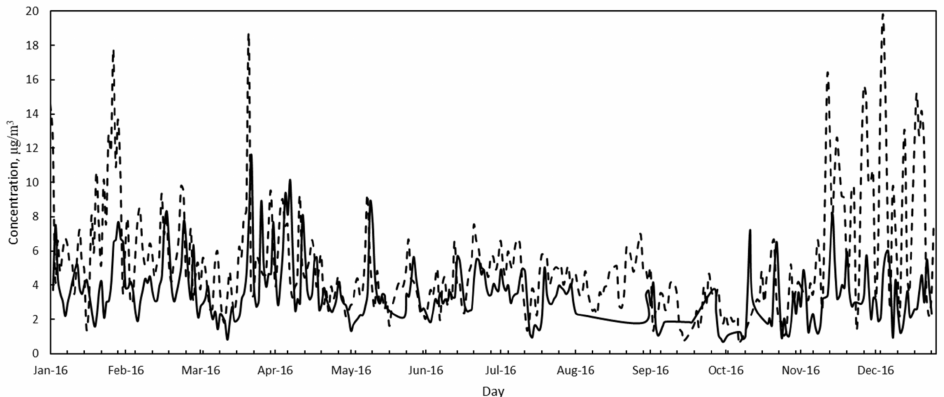
Figure 7. Nickel daily average concentrations measured in the HI (dashed black line) and LI (solid black line) area during 2016 from the ARPAC